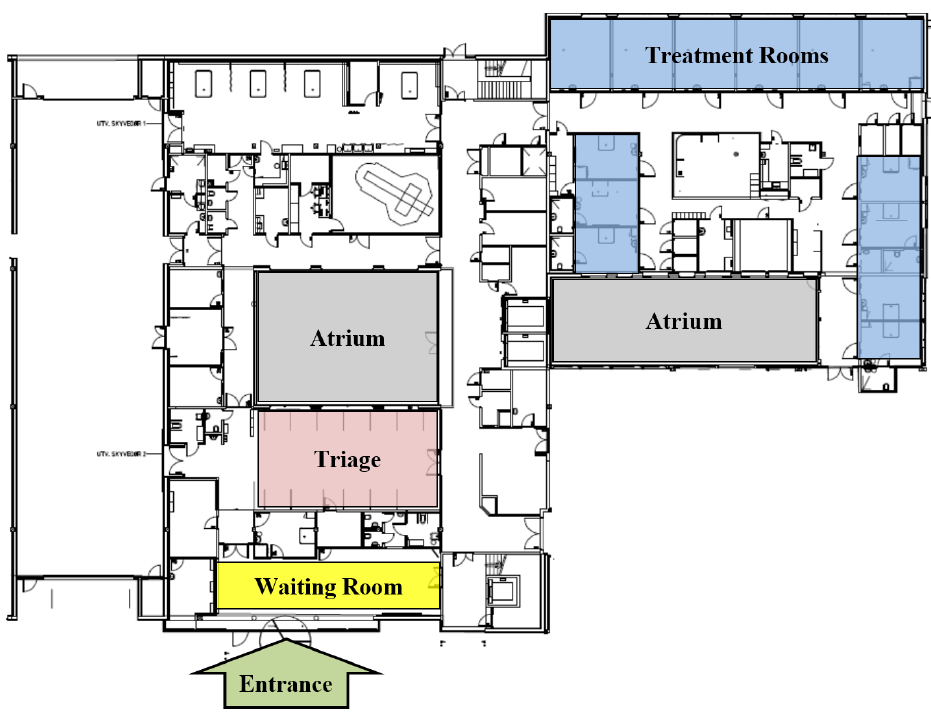
Figure 9. Blueprint of the studied ED before the pandemic measures was put in place.